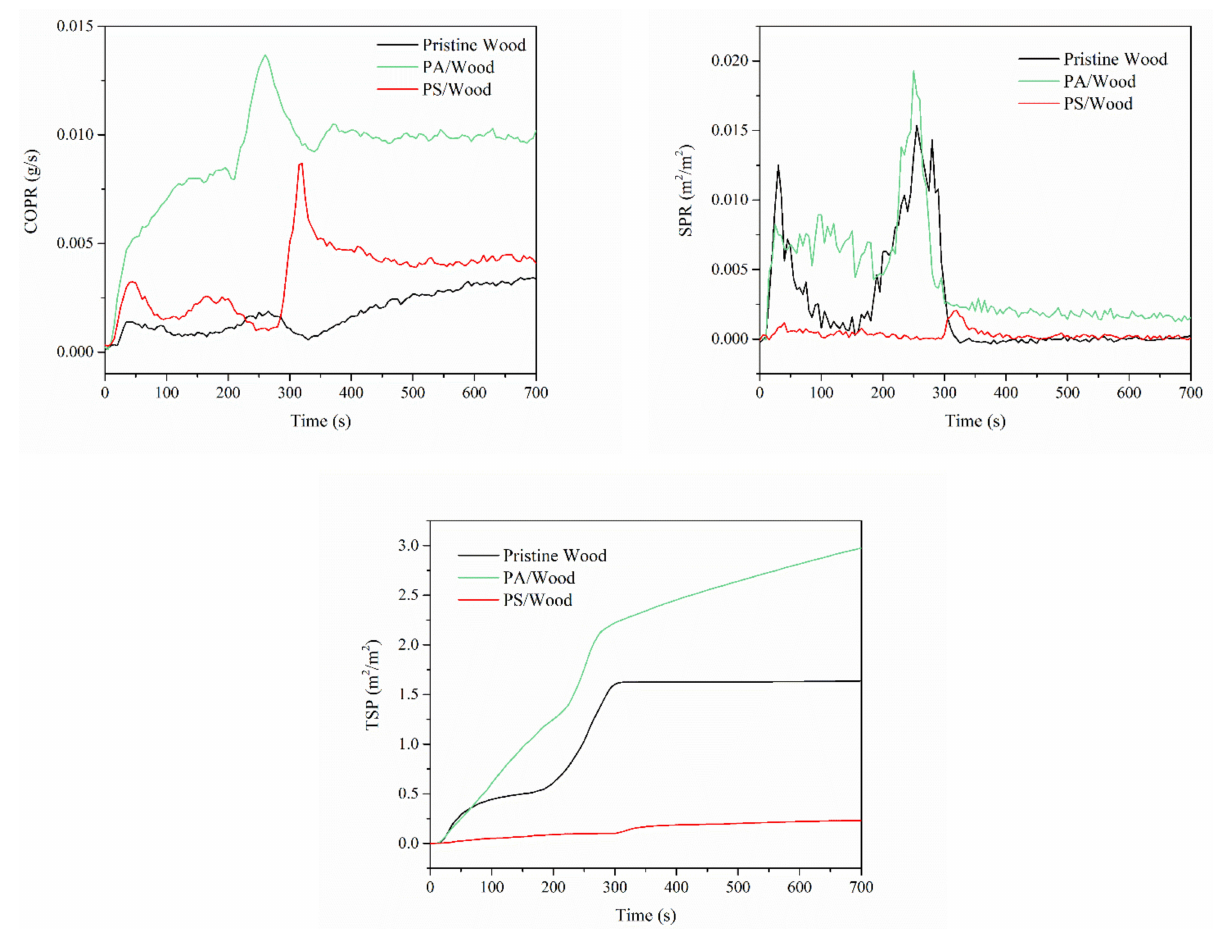
Figure 9. COPR, SPR, and TSP profiles of the wood samples. Table 5. CO and smoke parameters of the wood samples during